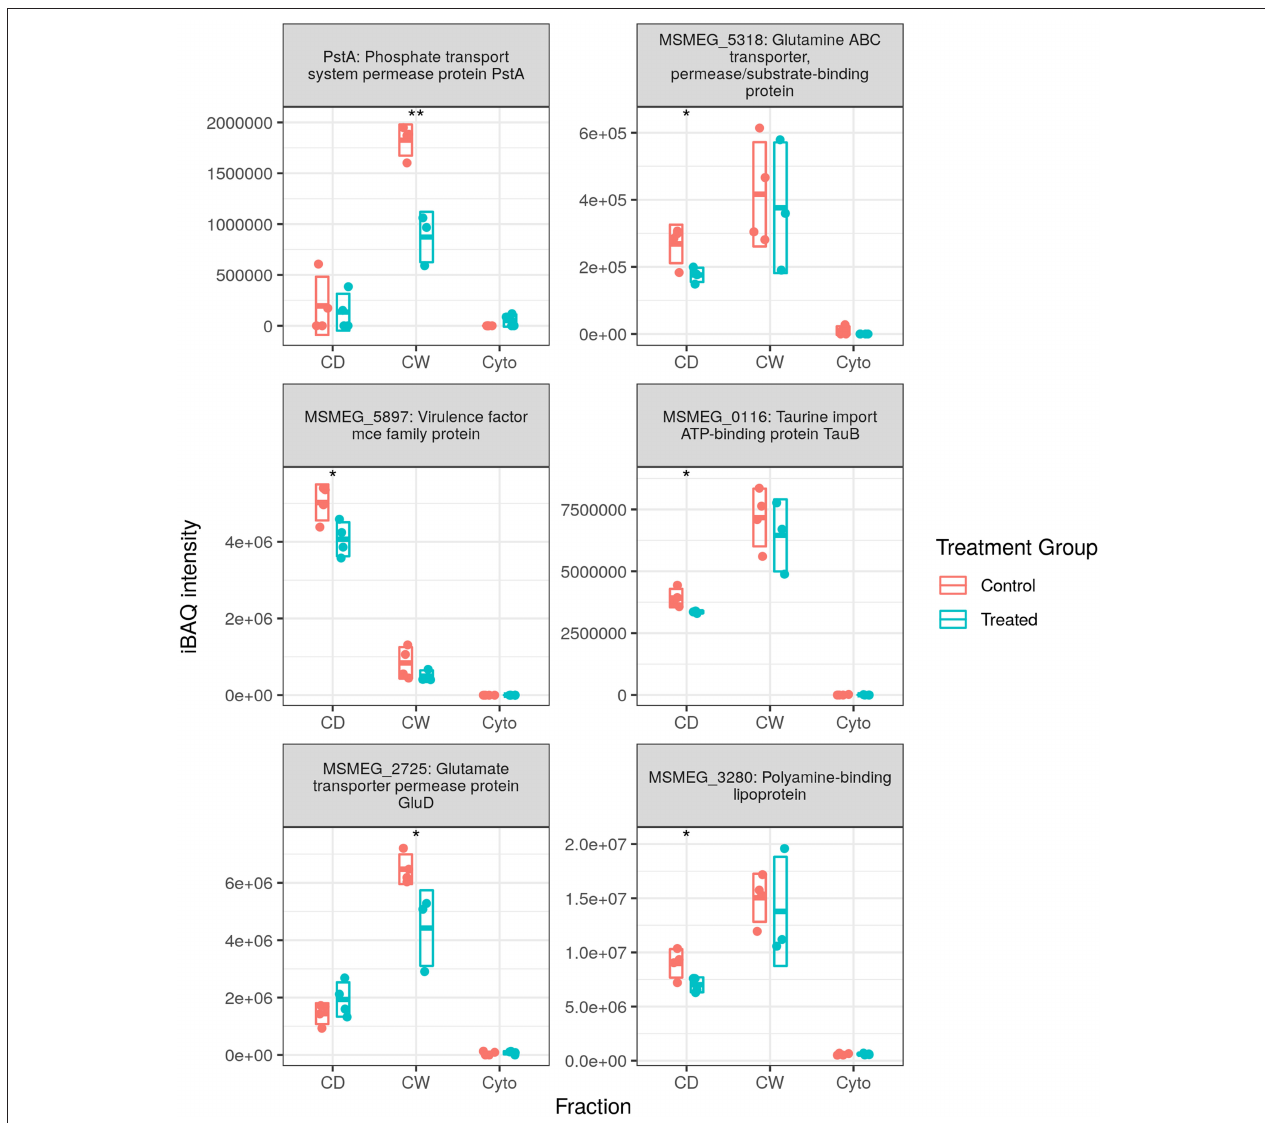
FIGURE 5 | Dysregulated ATP-binding cassette (ABC) transporter proteins. Examples of protein abundance distributions for several ABC transporter proteins across the different fractions in SL mycobacteria. Points indicate individual replicate values and the bars the mean plus/minus SD. Blue indicates control and red rifampicin-treated samples. * and ** indicate p < 0.05 and p < 0.01